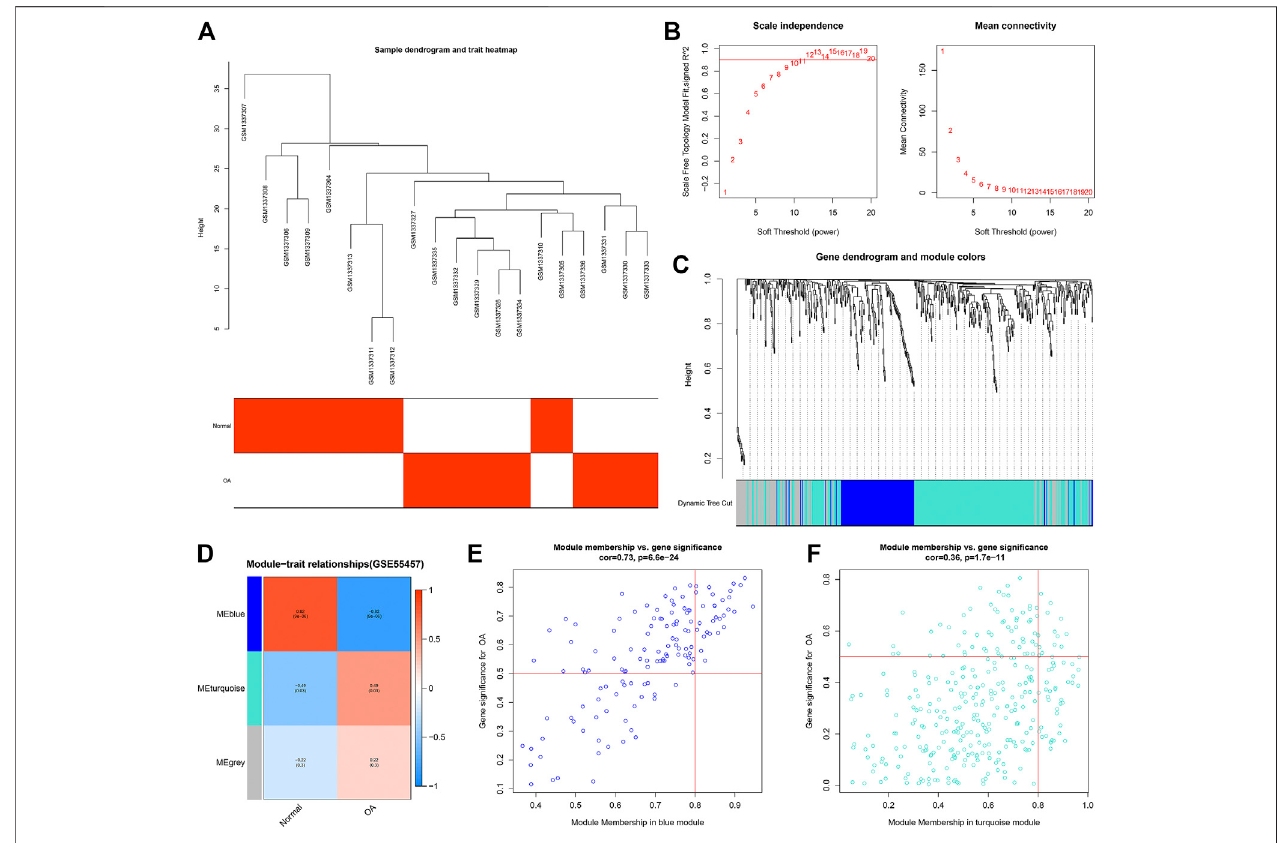
FIGURE 3 | Construction of co-expression modules for OA in the GSE55457 dataset. (A) Heatmap showing sample dendrogram and clinical traits. (B) Determination of the appropriate soft-thresholding power ( β ). (C) Gene dendrogram. Each color expresses a module. (D) Heatmap for correlations between modules and clinical traits. (E,F) Scatter plots for the correlations between GS and MM in the blue and turquoize modules.